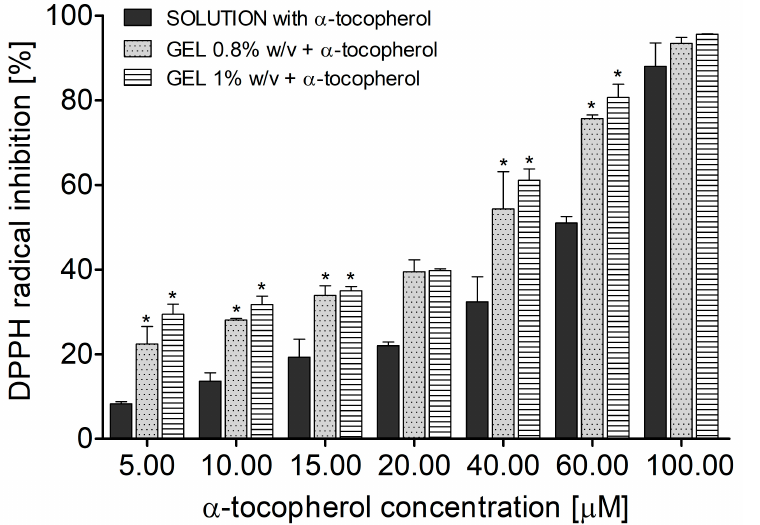
Figure 2. DPPH radical inhibition (%) by α -tocopherol in EtOH solution and in gels with 0.8% or 1% w / v of Boc-L-DOPA(Bn) 2 -OH, in DMSO:H 2 O (7:3 v / v ) (mean value ± SD, n = 3). The stars (*) above the columns indicate a statistically significant difference ( p < 0.05) between α -tocopherol in a specific concentration in solution vs. gel.